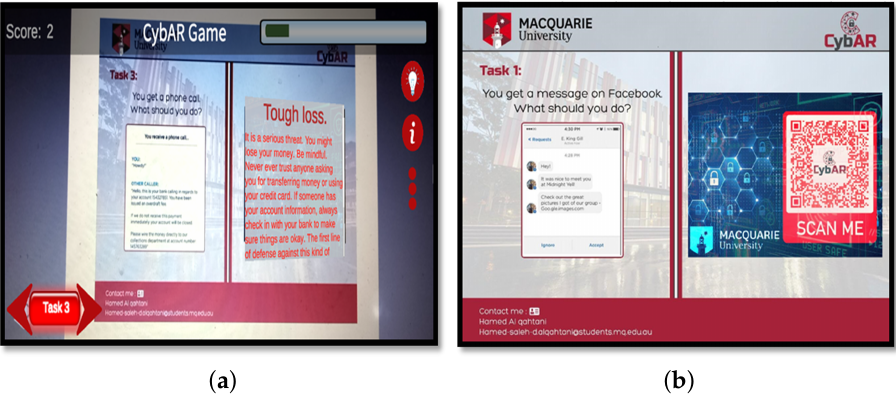
Figure 3. ( a ) Feedback after making a wrong decision. ( b ) Example of CybAR